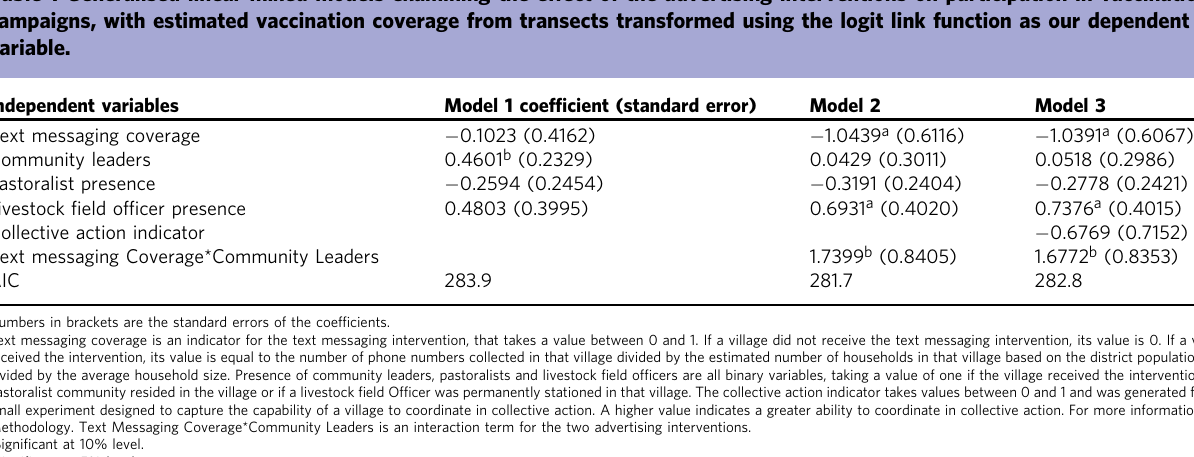
Table 1 Generalised linear mixed models examining the effect of the advertising interventions on participation in vaccination campaigns, with estimated vaccination coverage from transects transformed using the logit link function as our dependent variable.